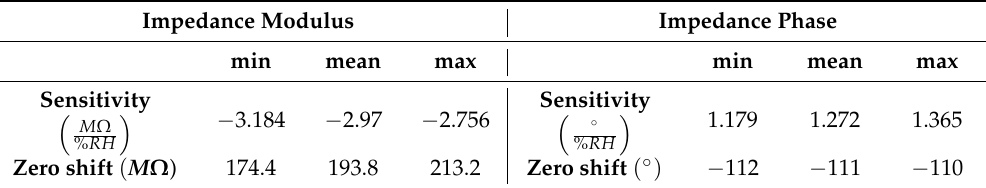
Figure 5. Sensor impedance at 200 Hz with a 95% of confidence interval. Red line represents the average measured impedance with 95% confidence interval error, continuous black line represents the linear regression for the average value, and the dotted and dashed lines represent the linear regression for +9% confidence interval and − 95% of confidence interval, respectively. The linear regression equations are also shown in the graph. ( a ) impedance modulus ( b ) impedance phase. Table 1. Sensor impedance properties with process variability for 95% interval of confidence.